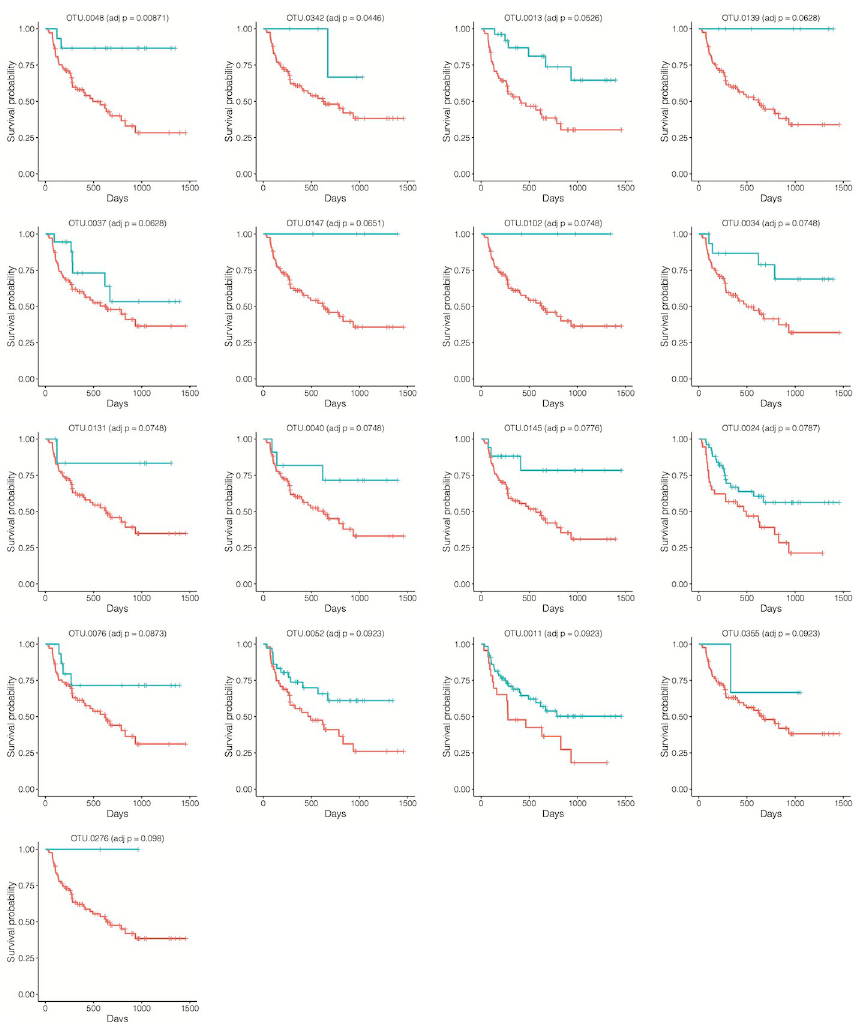
Fig 4. Survival functions for the overall survival outcome by the presence (blue) and absence (red) status (based on a singly rarefied OTU table) of the OTUs detected by LDM-c. The plots were ordered by the adjusted p -values from